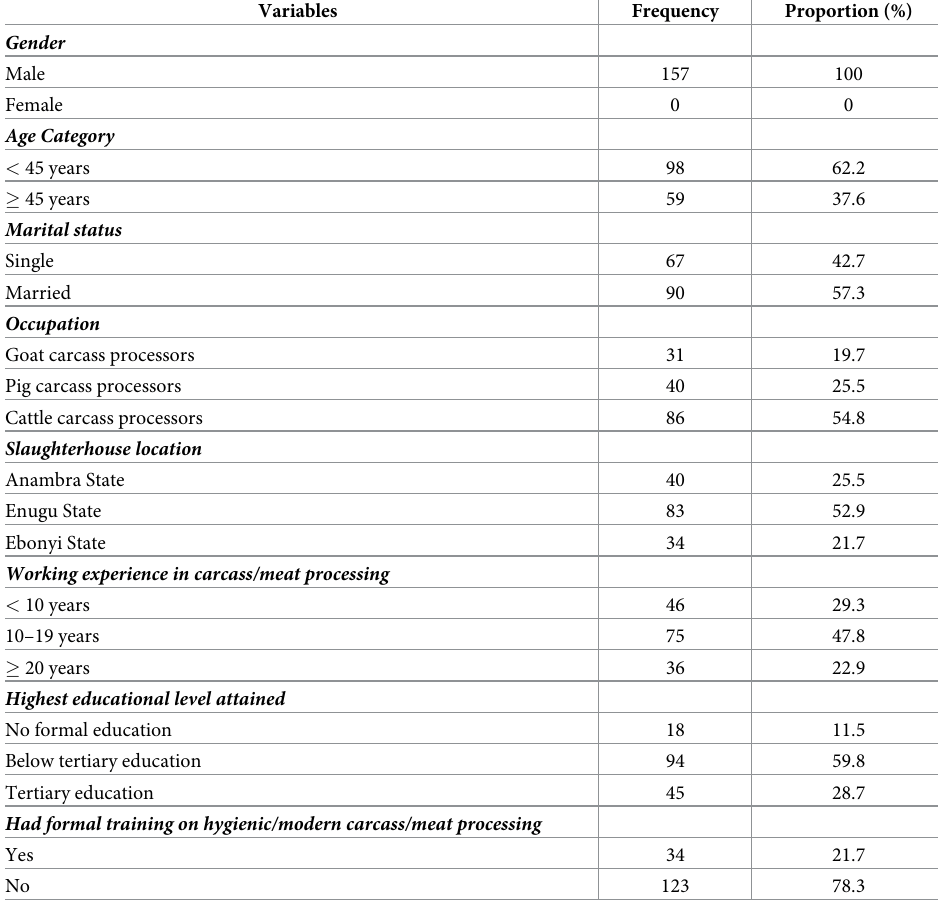
Table 1. Socioeconomic characteristics of slaughterhouse workers (n = 157) surveyed in Southeast Nigeria.